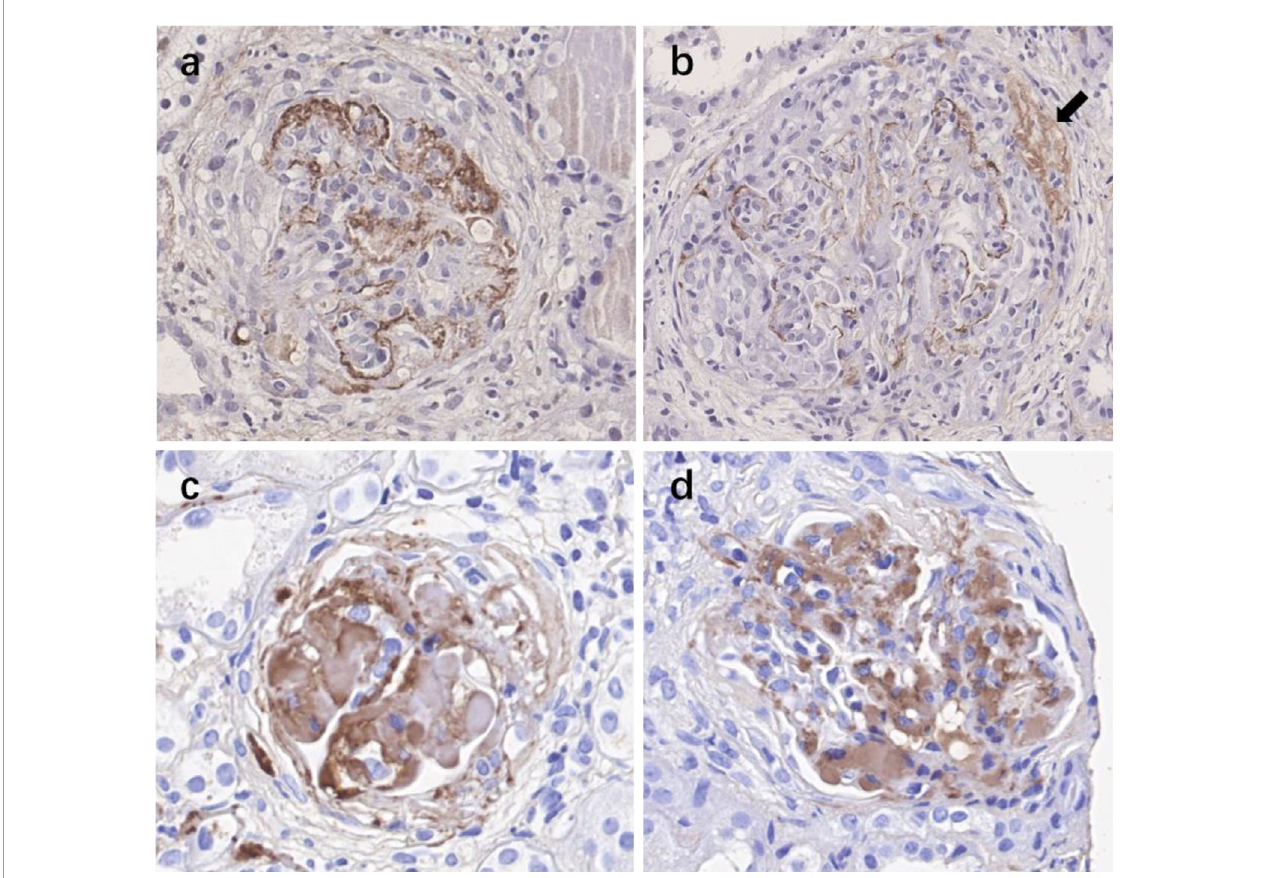
FIGURE 3 | Immunohistochemistry staining for complement activation products C4d, C3d, and C5b-9 in kidney specimens of IgAN patients with various crescent formations. (A) Positive staining of C4d in the mesangial area of the glomerulus. (B) Positive staining of C4d both in the mesangial area of the glomerulus and within the crescent (black arrow). (C) Positive staining of C5b-9. (D) Positive staining of C3d. IgAN, IgA nephropathy.